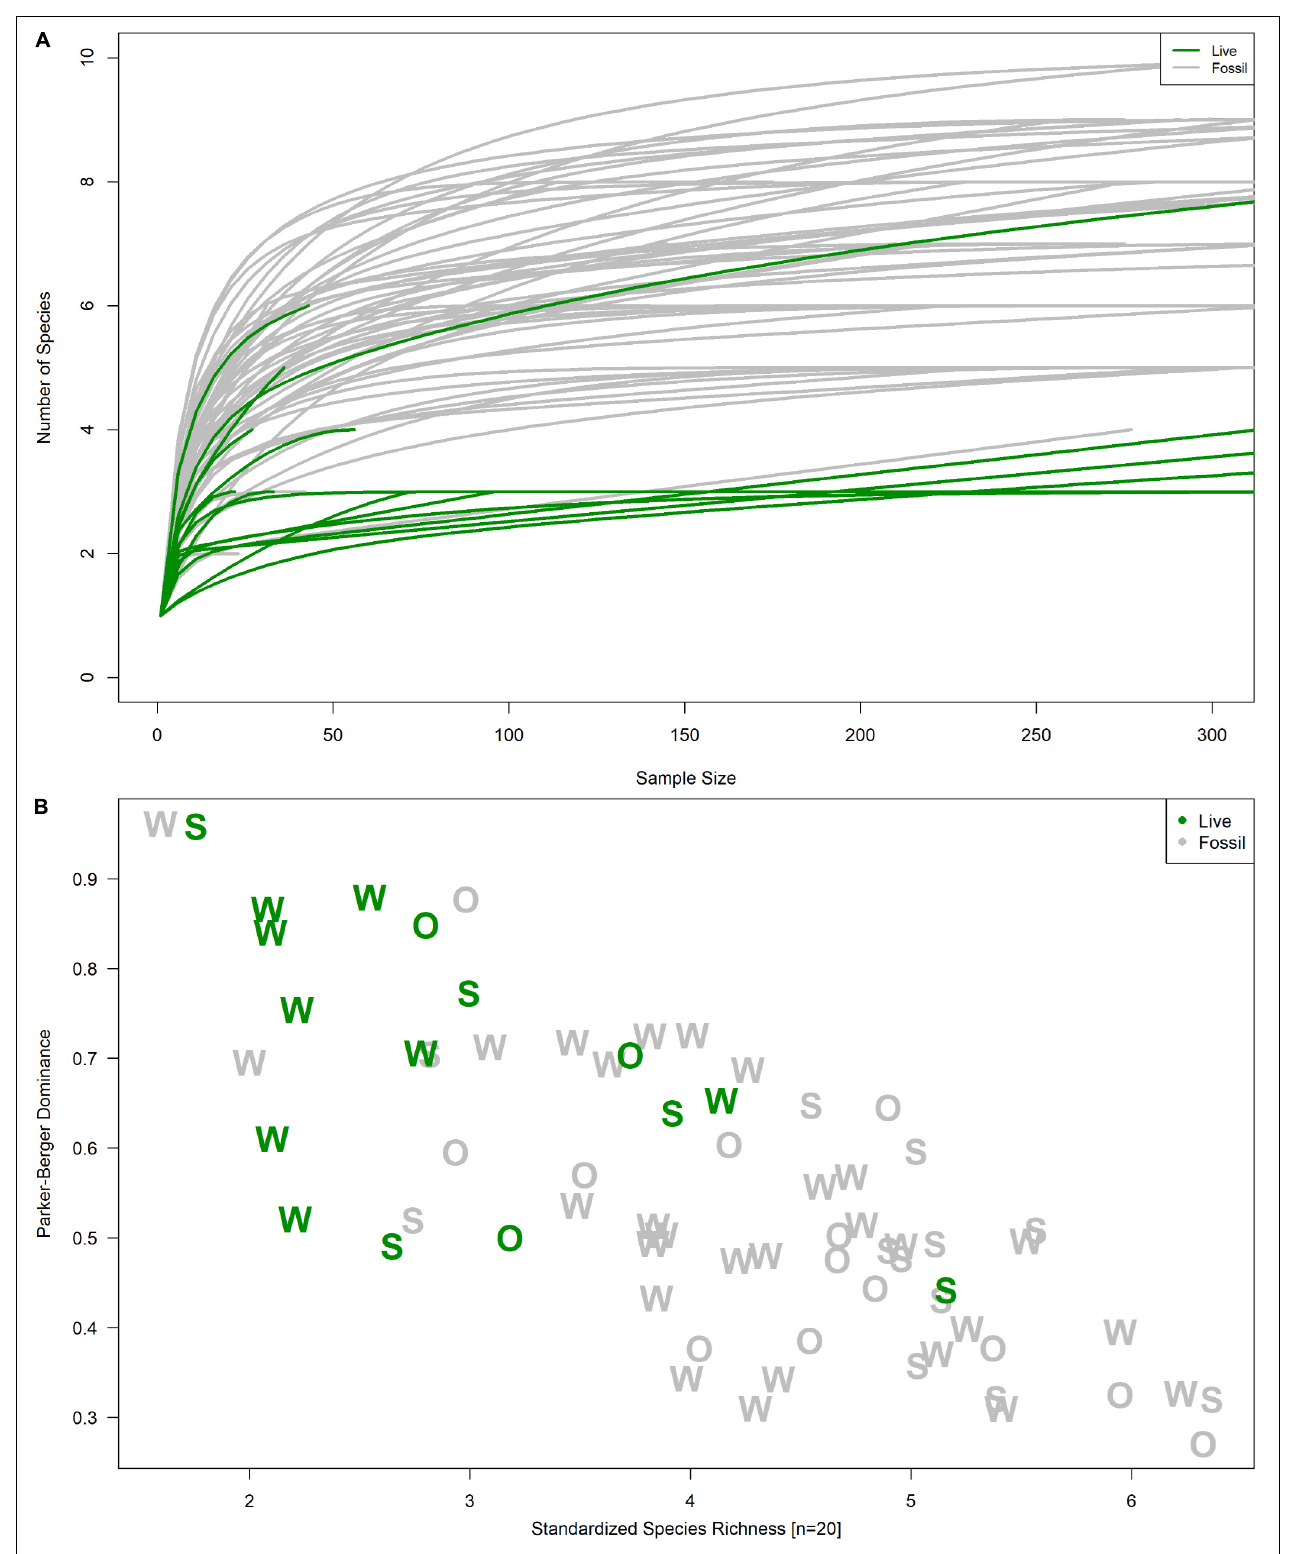
FIGURE 3 | (A) Rarefaction curves and (B) richness-dominance plot and of fossil (gray) and live (green) samples. Letters in (B) correspond to a sample’s river system: “W” for Wakulla, “S” for Silver, and “O” for Ocklawaha.